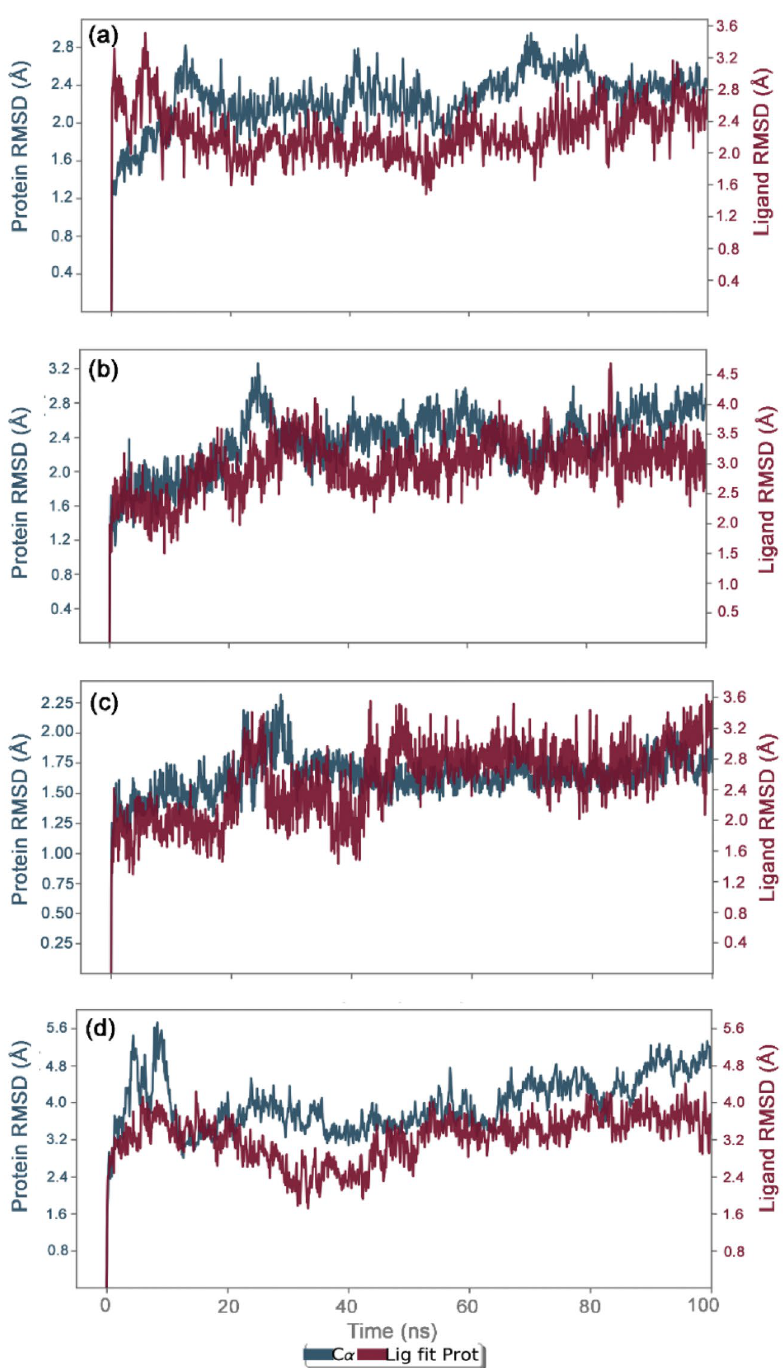
Figure 4. RMSD plots for the backbone atoms of jRdRp and selected bioactive compounds, i.e., ( a ) Gedunin ( b ) Nimbolide ( c ) Ohchinin acetate, ( d ) Kulactone fit on protein were extracted from 100 ns MD simulation trajectories of respective docked